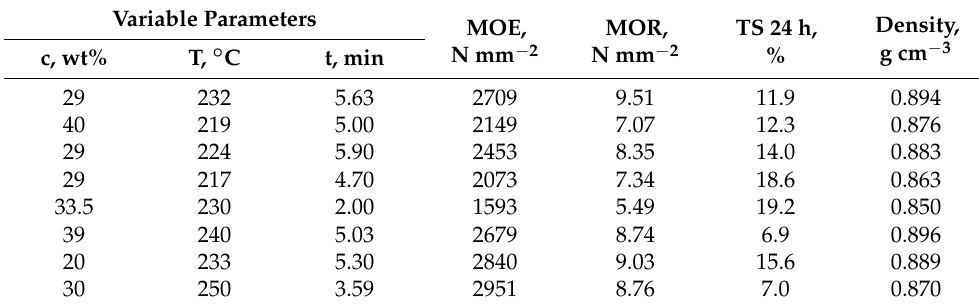
Table 9. Characteristics of particle boards, depending on the pressing parameters (additional points). Variable